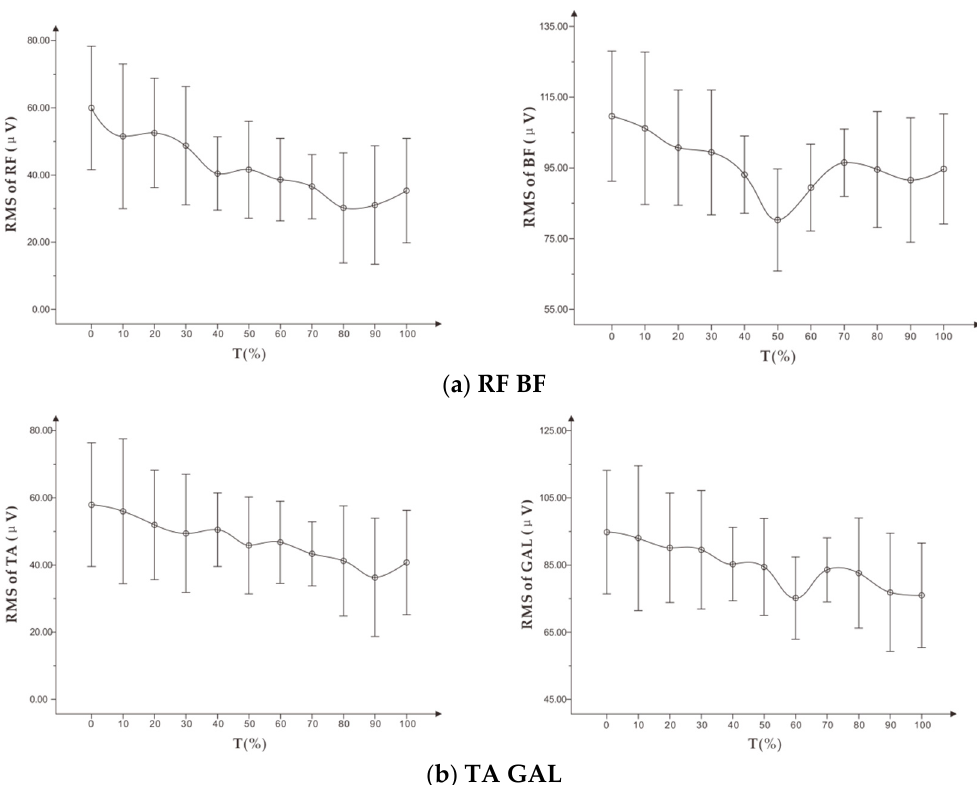
Figure 9. ( a ) shows the trend of RMS (x ± s) on RF, BF, and ( b ) shows the trend of RMS (x ± s) on TA, GAL in standardized time in the constant load experiment.